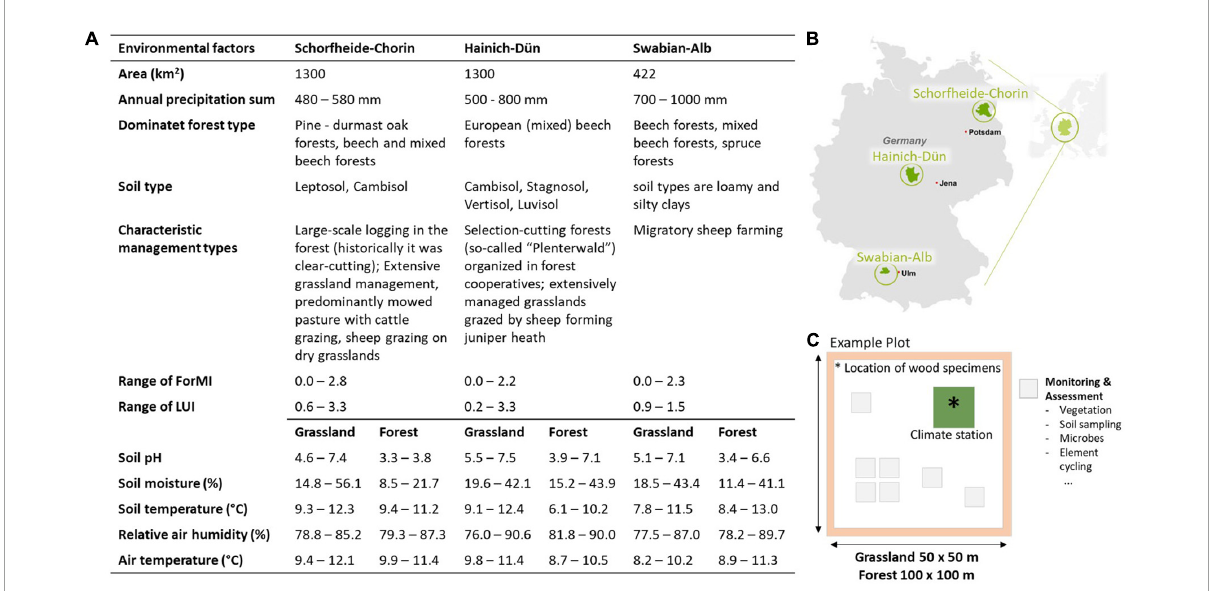
FIGURE1 Range of environmental factors (A) and region (B) of the Exploratories Schorfheide-Chorin, Hainich-Dün, and Swabian-Alb in Germany. Each region consists of 50 forest and 50 grassland plots, which are structured in a similar pattern, each with a climate station where all wood specimens were placed (see Supplementary Figure 1 ) and additional stations for monitoring and assessment (C) . LUI, land-use intensity, ForMI: forest management intensity. Details for the indices can be found in Table 1 and Supplementary Tables 2 , 3 and the definition of indices by Blüthgen et al. (2012), Kahl and Bauhus